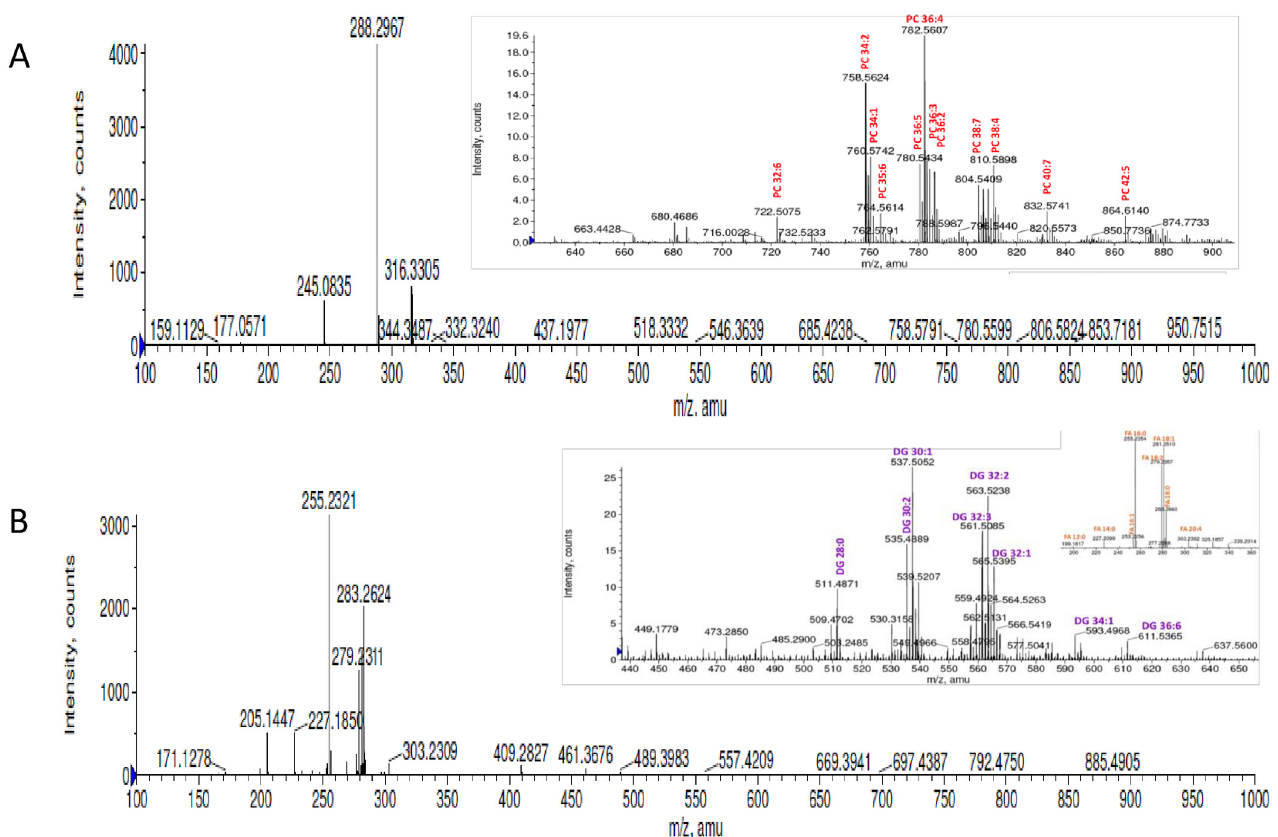
Fig 1. ESI mass spectrum of lipid extract of the serum sample from PCa patient recorded in a) Positive ion mode b) Negative ion mode.